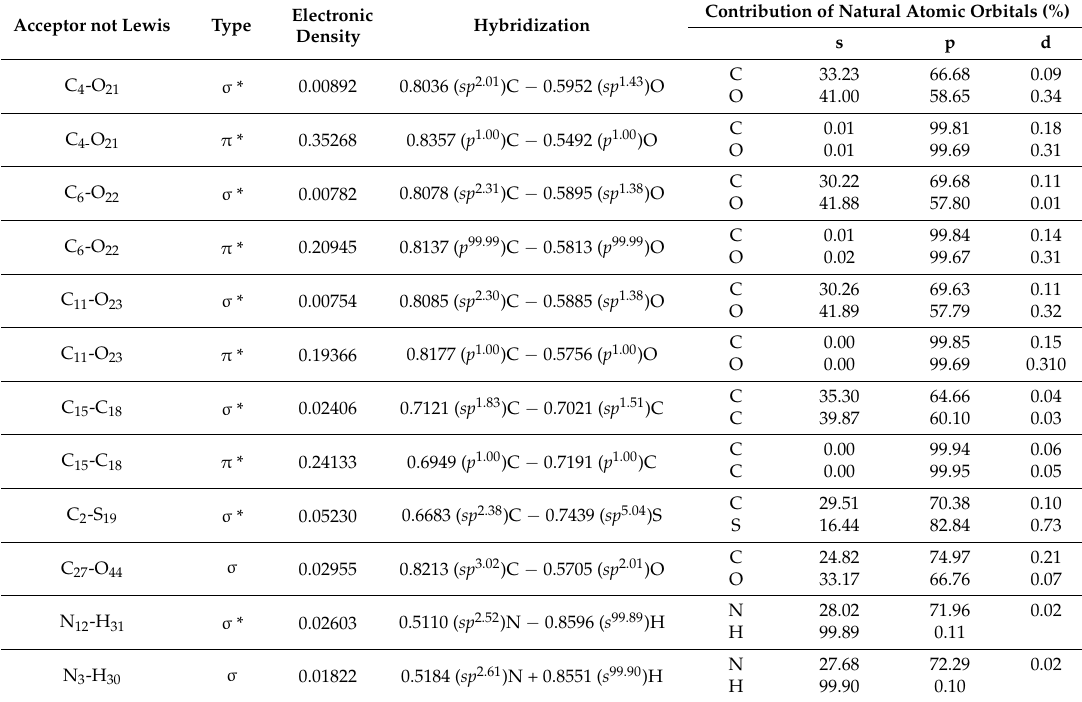
Table 6. Occupation of natural bond orbitals (NBO) no Lewis and hybrids for 4c calculated by the DFT/B-3LYP/6-31G(d,p) method for the representative atoms. Contribution of Natural Atomic Orbitals Electronic Acceptor not Lewis Type Hybridization Density